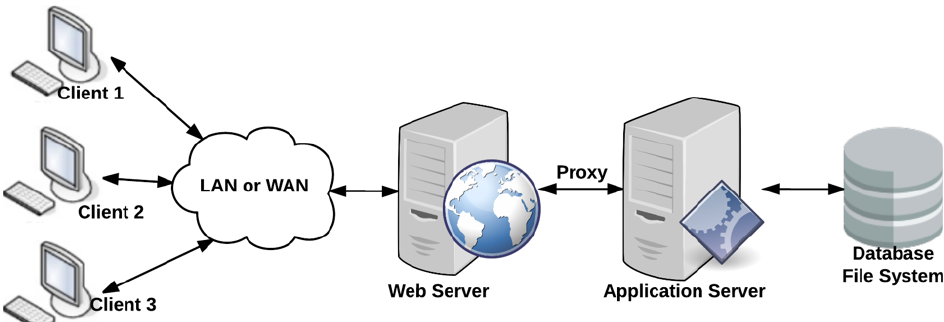
Figure 5. Browser/server architecture of our heuristic system. An application server is used to process the climate data. The web server communicates with an application server through a web